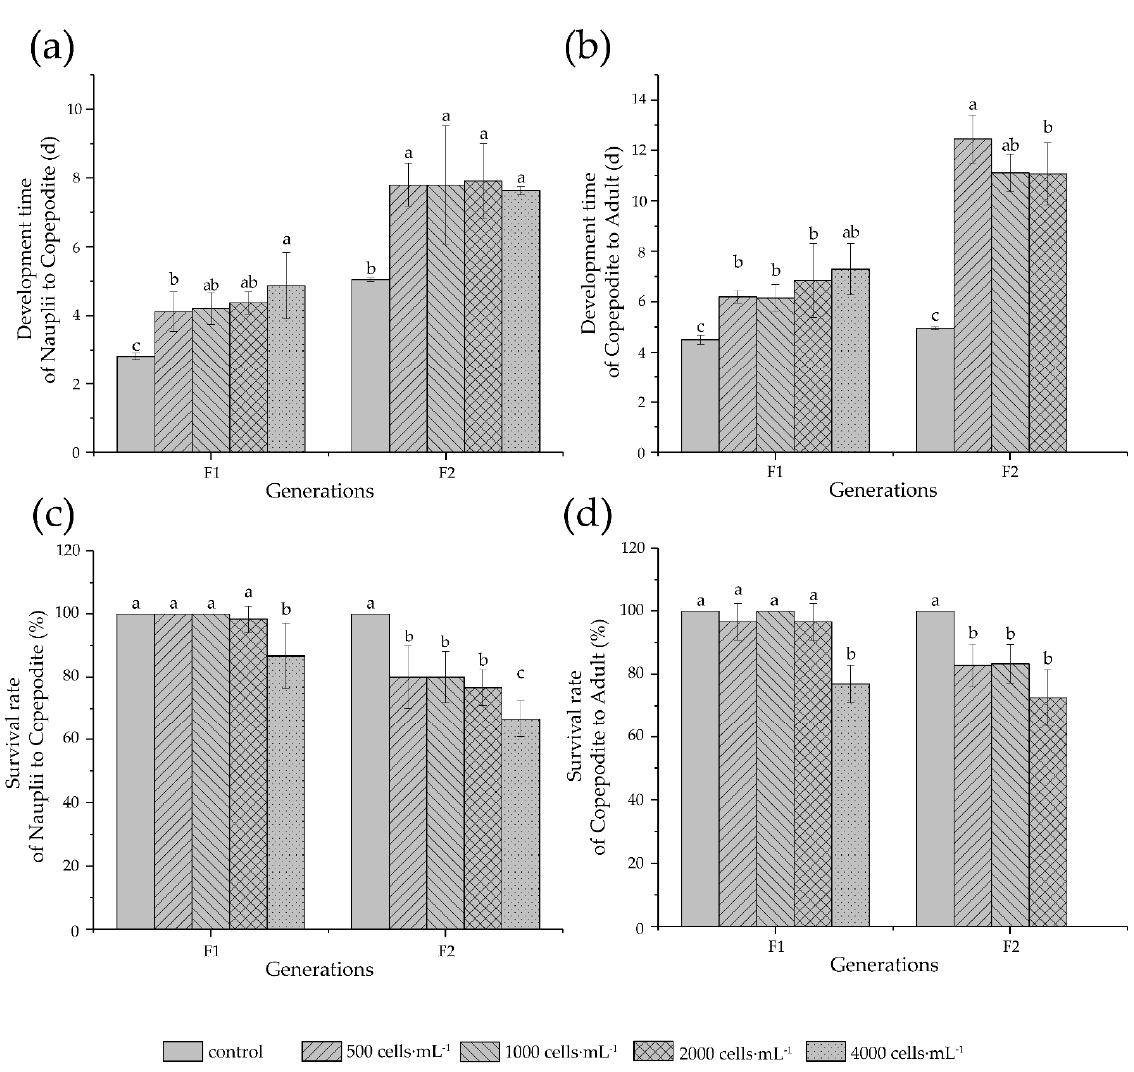
Figure 4. Development time ( a , b ) and survival rate ( c , d ) in two generations of T. japonicus exposed to different K. mikimotoi concentrations. ( a , c ), nauplius to copepodid stage, ( b , d ), copepodid to adult stage. Different letters indicate a significant difference among groups at p < 0.05.